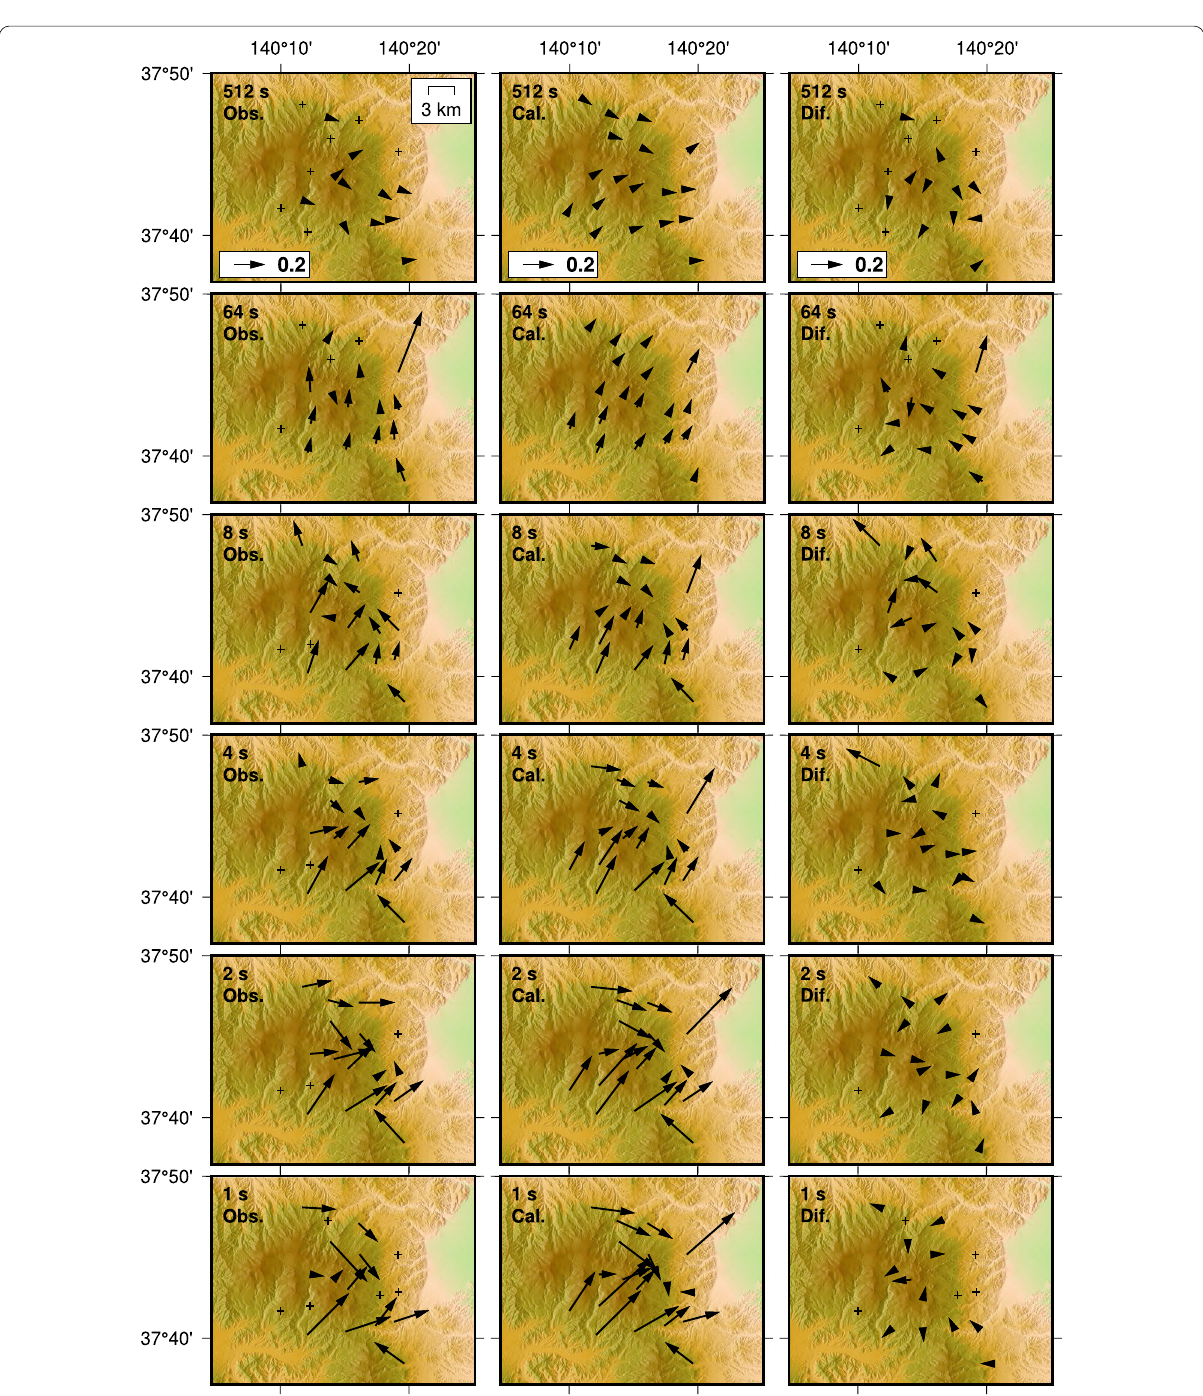
Fig. 9 Observed (left column), calculated (center column), and difference between observed and calculated (right column) in-phase Parkinson vectors of all sites at various periods or frequencies. The calculated vectors are obtained with the final resistivity model (Figs. 5, 6,